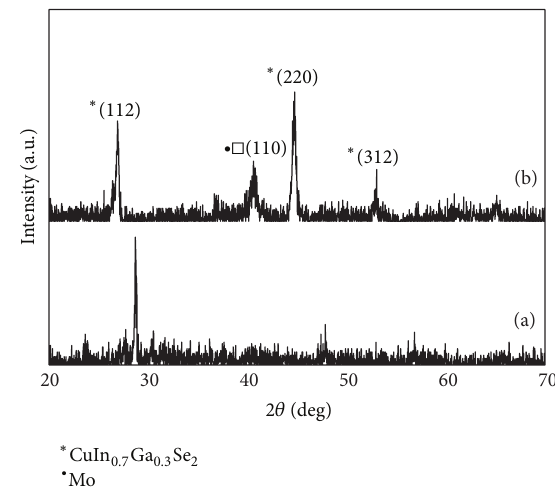
Figure 3: XRD pattern of thin film deposited under potentials − 1350 mV versus SCE for (a) as-annealing and (b) annealing under Ar atmosphere.